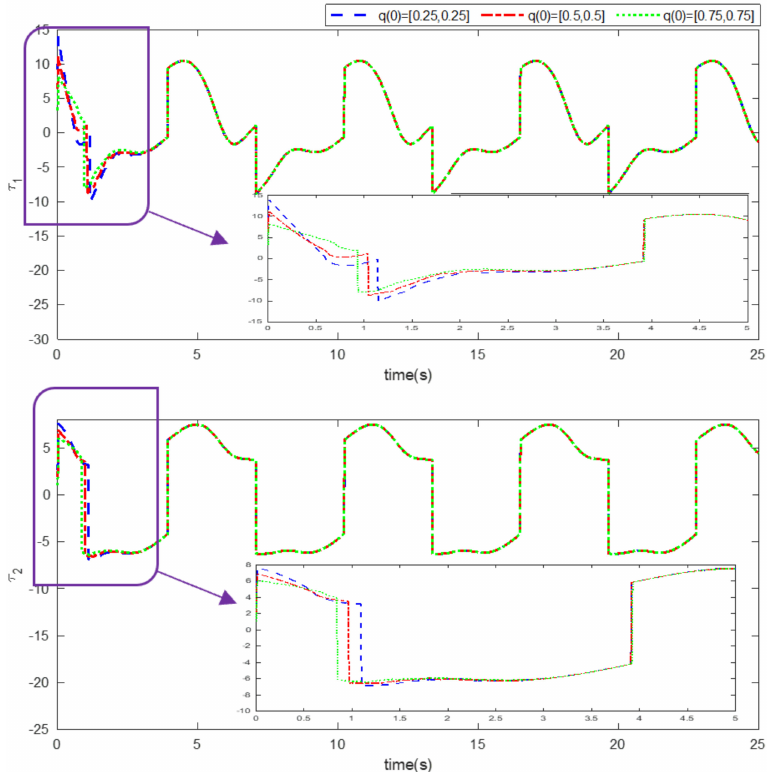
Figure 12. Control input under different initial conditions. (Example